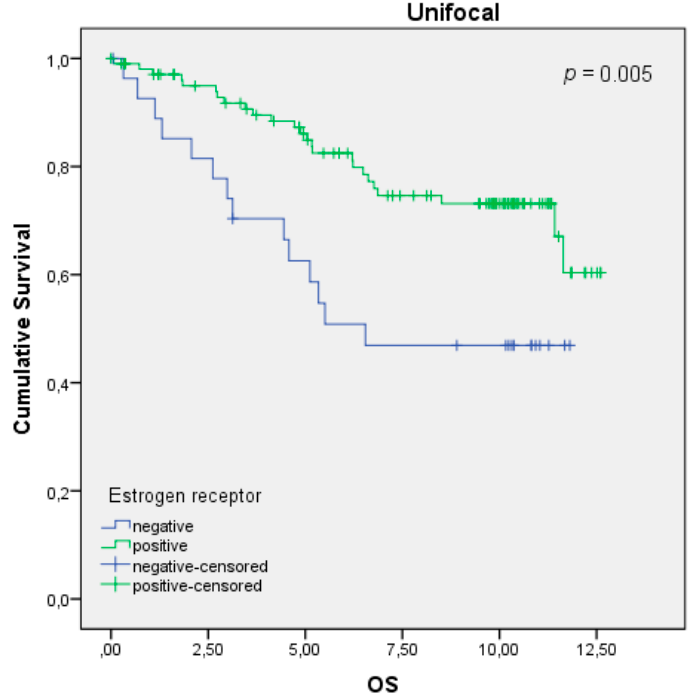
Figure 1. Kaplan–Meier survival analysis among estrogen receptor (ER)-positive and -negative patients. Overall survival (OS) of patients with unifocal breast cancer (BC) in years. Table 1. Significant results for the estrogen receptor-positive patients.